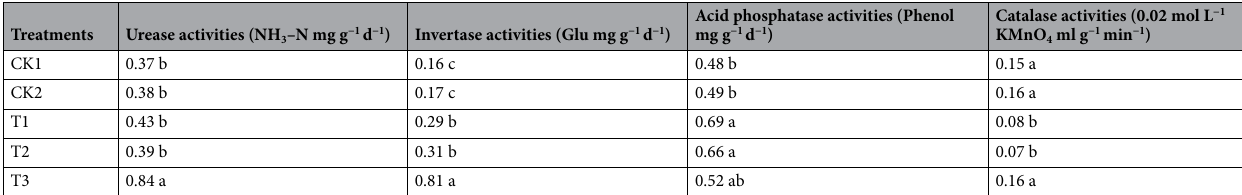
Table 3. Effect of straw biochar application on soil enzyme activities. Different letters in each column indicate significant differences ( p < 0.05) among the treatments for each parameter.